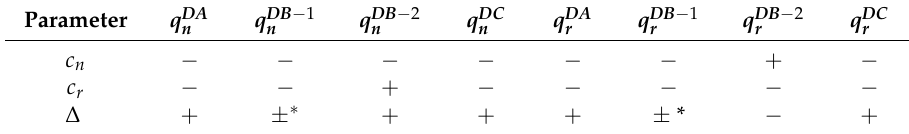
Table 6. Sensitivity analysis of the manufacturer’s optimal production